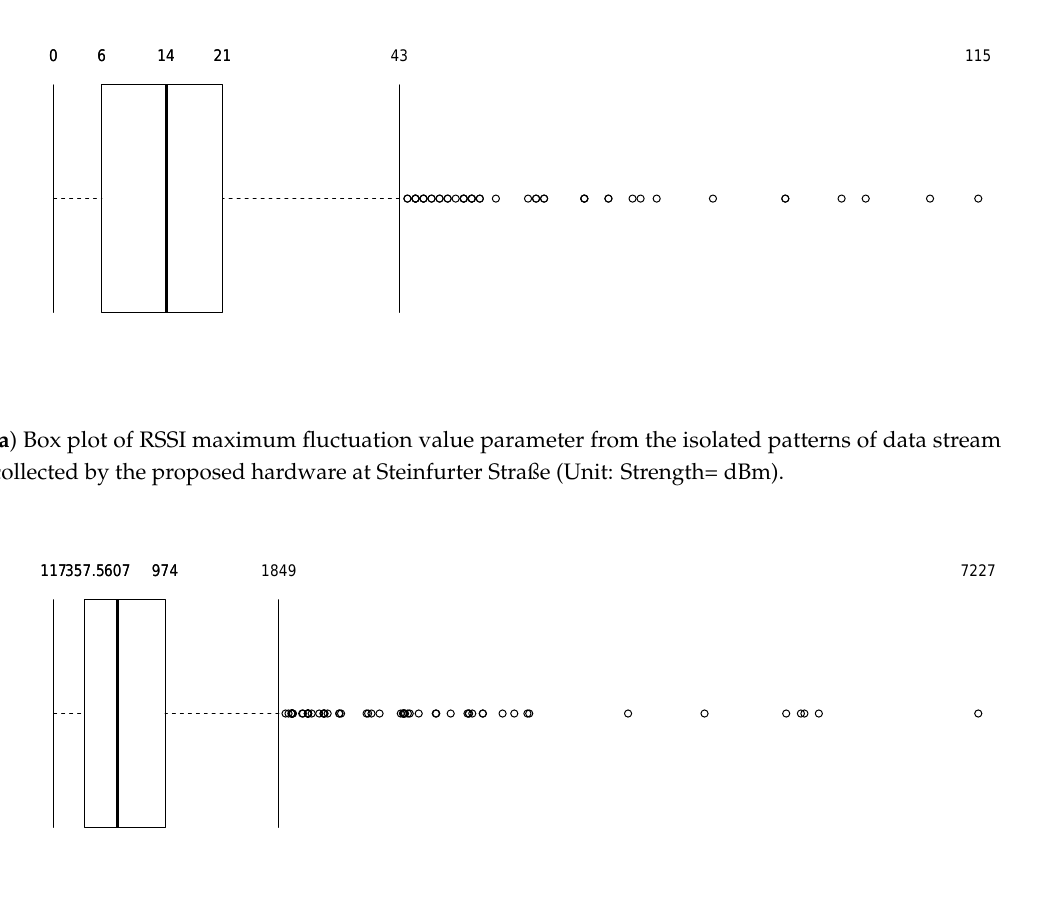
( b ) Box plot of time window size value parameter from the isolated patterns of data stream collected by the proposed hardware at Steinfurter Straße (Units: Time= Milliseconds). Figure 9. Parameters summary statistics for Steinfurter